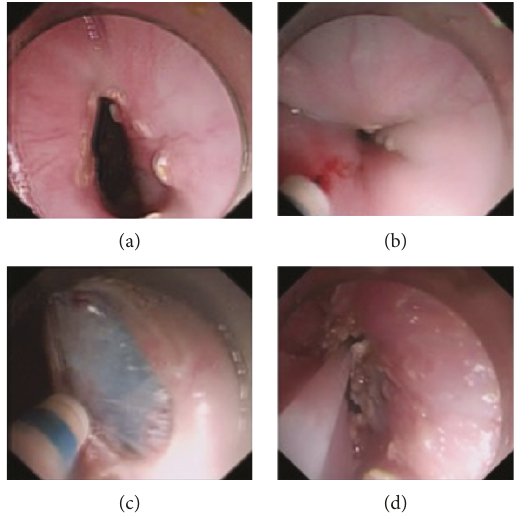
Figure 2: Procedures of ARMS: (a) marking; (b) submucosal injection; (c) mucosal resection; (d) submucosal excision; Figure 2 is reproduced from Li et al. [17] (under the Creative Commons Attribution License/public